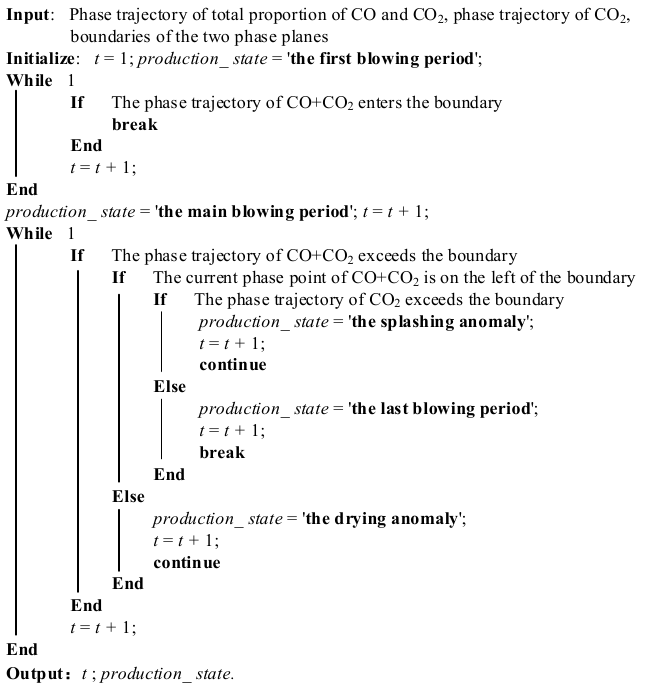
Figure 4. The check procedure for production state characterization.